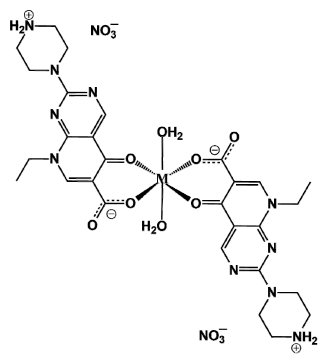
Figure 2. General representation of complexes I–III : (M(PA) 2 (H 2 O) 2 )(NO 3 ) 2 , where M = Mn(II), Zn(II) and Ca(II), respectively, and PA = pipemidic acid.